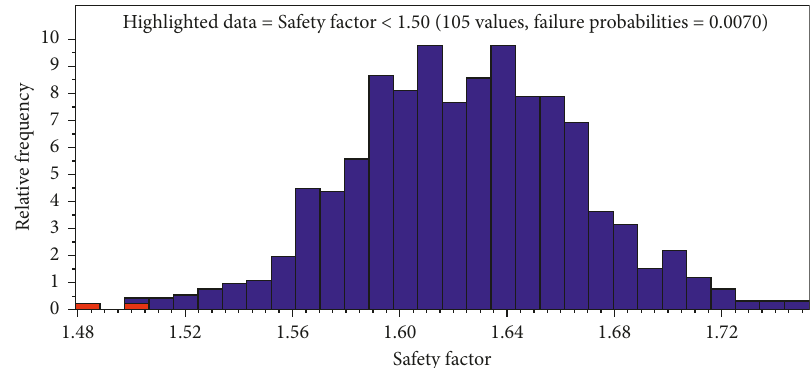
Figure 9: The relative frequency distribution for the safety factor of CPSN.